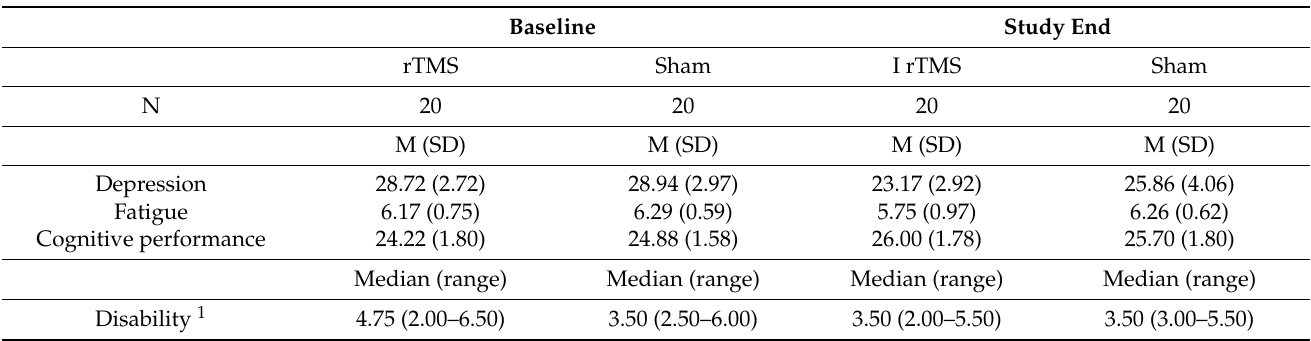
Table 2. Descriptive statistical overview of symptoms of depression and fatigue, cognitive perfor- mance and the degree of disability at baseline and at the end of the study, separately for the rTMS and for the sham condition.